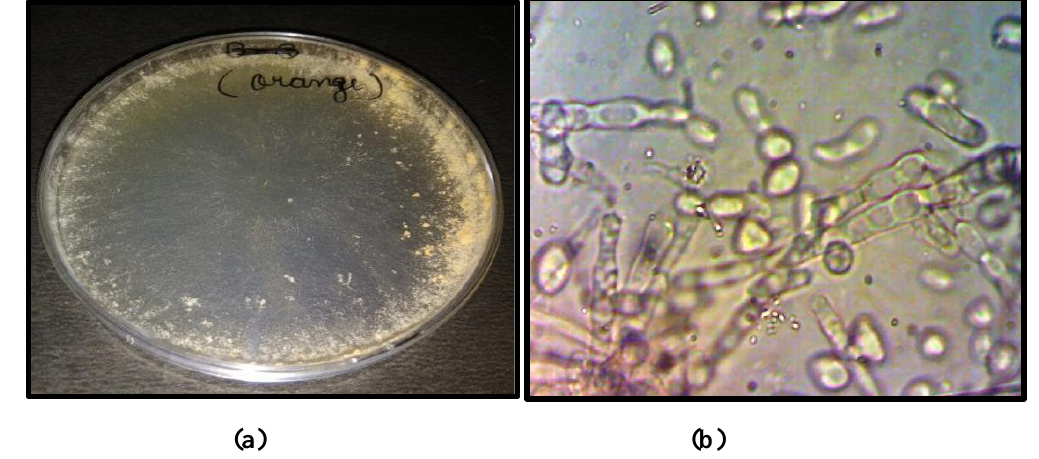
Figure 2. Neurospora sp. PAMS29 (a) Colony on PDA plate and (b) Conidiophore & conidia (under